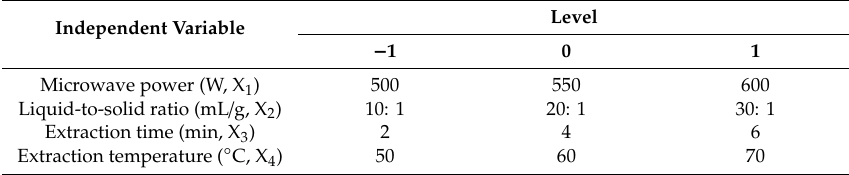
Table 6. The code and level of factors selected for the